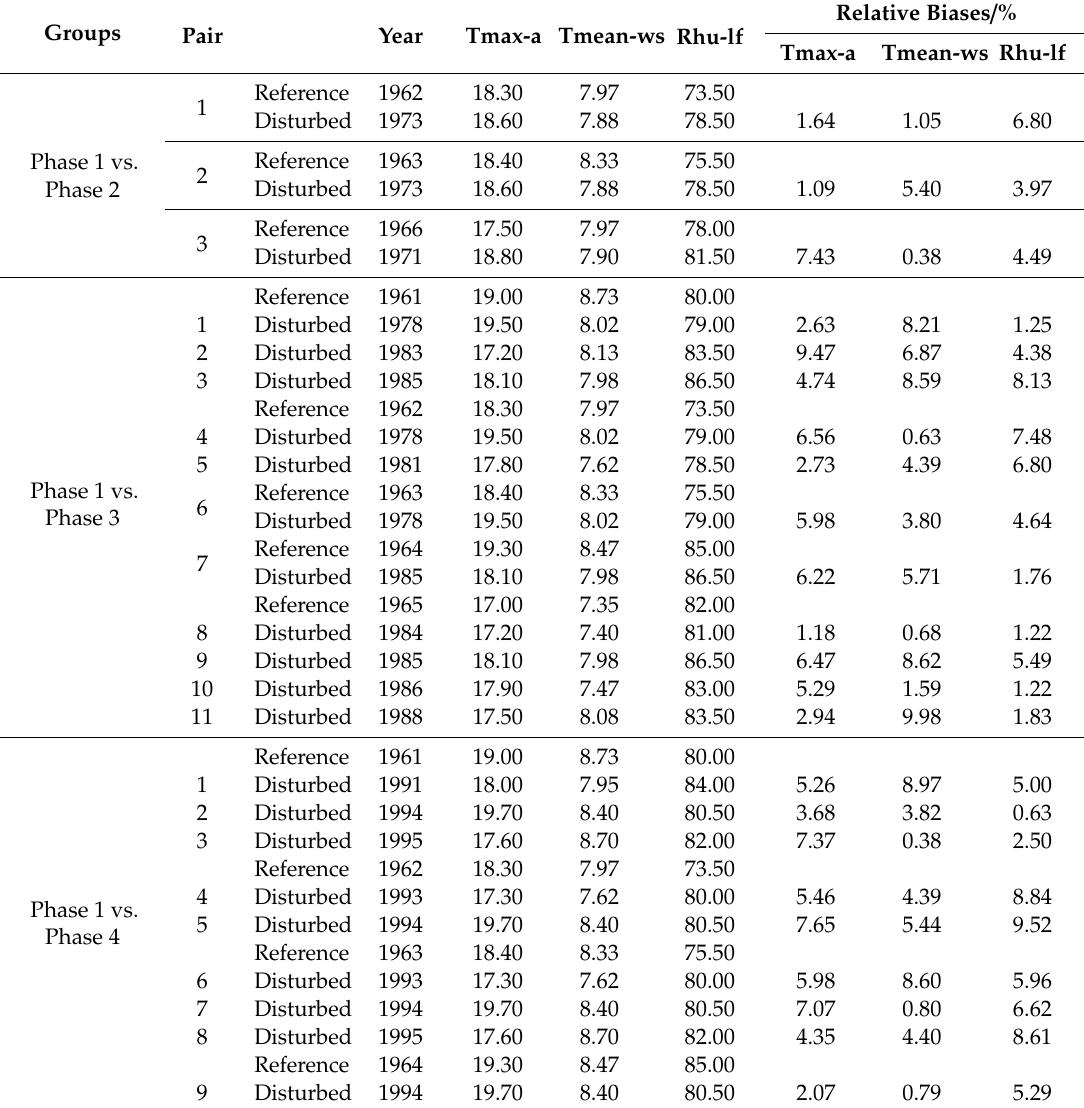
Table 2. Selected pairs for assessing the e ff ects of forest harvesting on flow regimes. Groups Pair